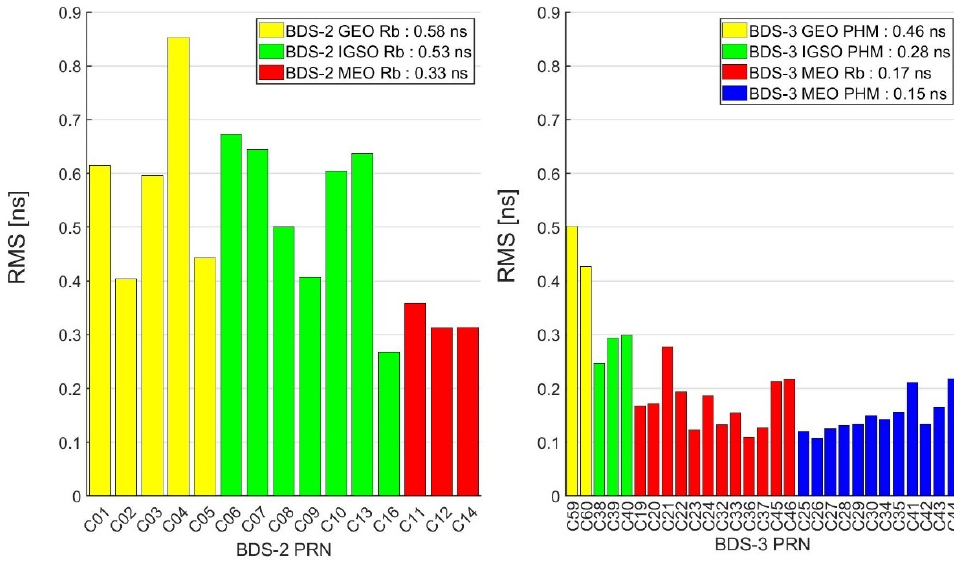
Figure 9. RMS of clock fitting residuals of BDS-2 and BDS-3 GEO, IGSO, and MEO satellites.